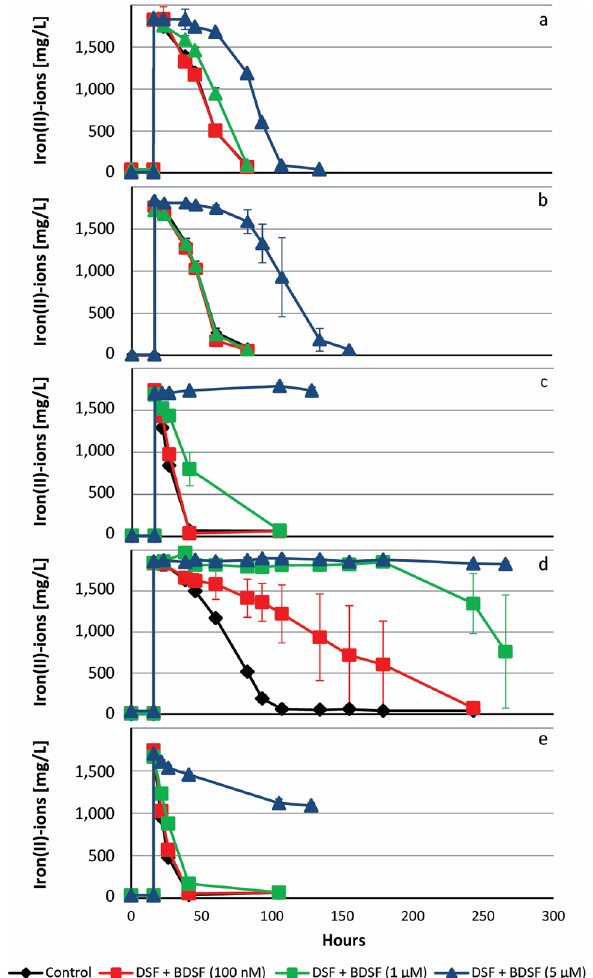
Figure 7. DSF and BDSF inhibit biological iron oxidation in various acidophilic bacteria. Cultures were inoculated with 10 7 cells/mL iron(II)-grown cells of At. ferrooxidans ATCC 53,993 ( a ), At. ferridurans T ( b ), L. ferrooxidans T ( c ), Acidiferrobacter sp. SPIII/3 DSM 27,195 ( d ), and S. thermosulfidooxidans T ( e ) and exposed to DSF ((Z)-11-methyl-2-dodecenoic acid) and BDSF ((Z)-2-dodecenoic acid) for 16 h before 32 mM iron(II)-ions were